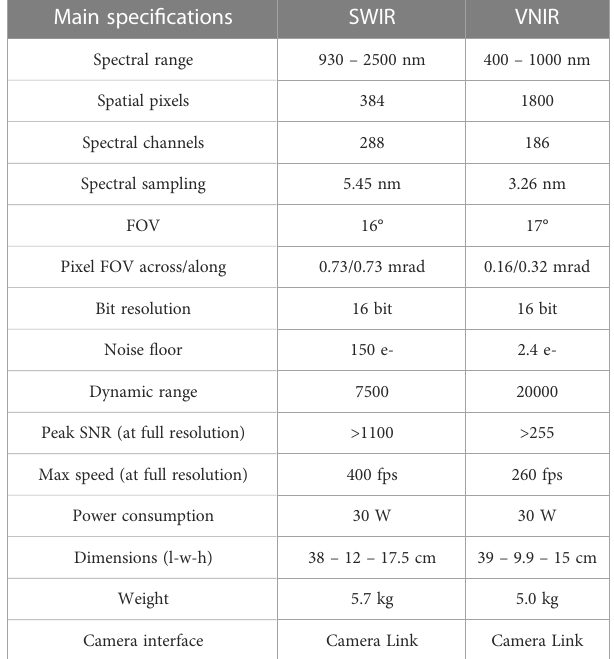
TABLE 1 Summary of hyperspectral imaging system, comparison of SWIR and VNIR camera speci fi cations. Main speci fi cations